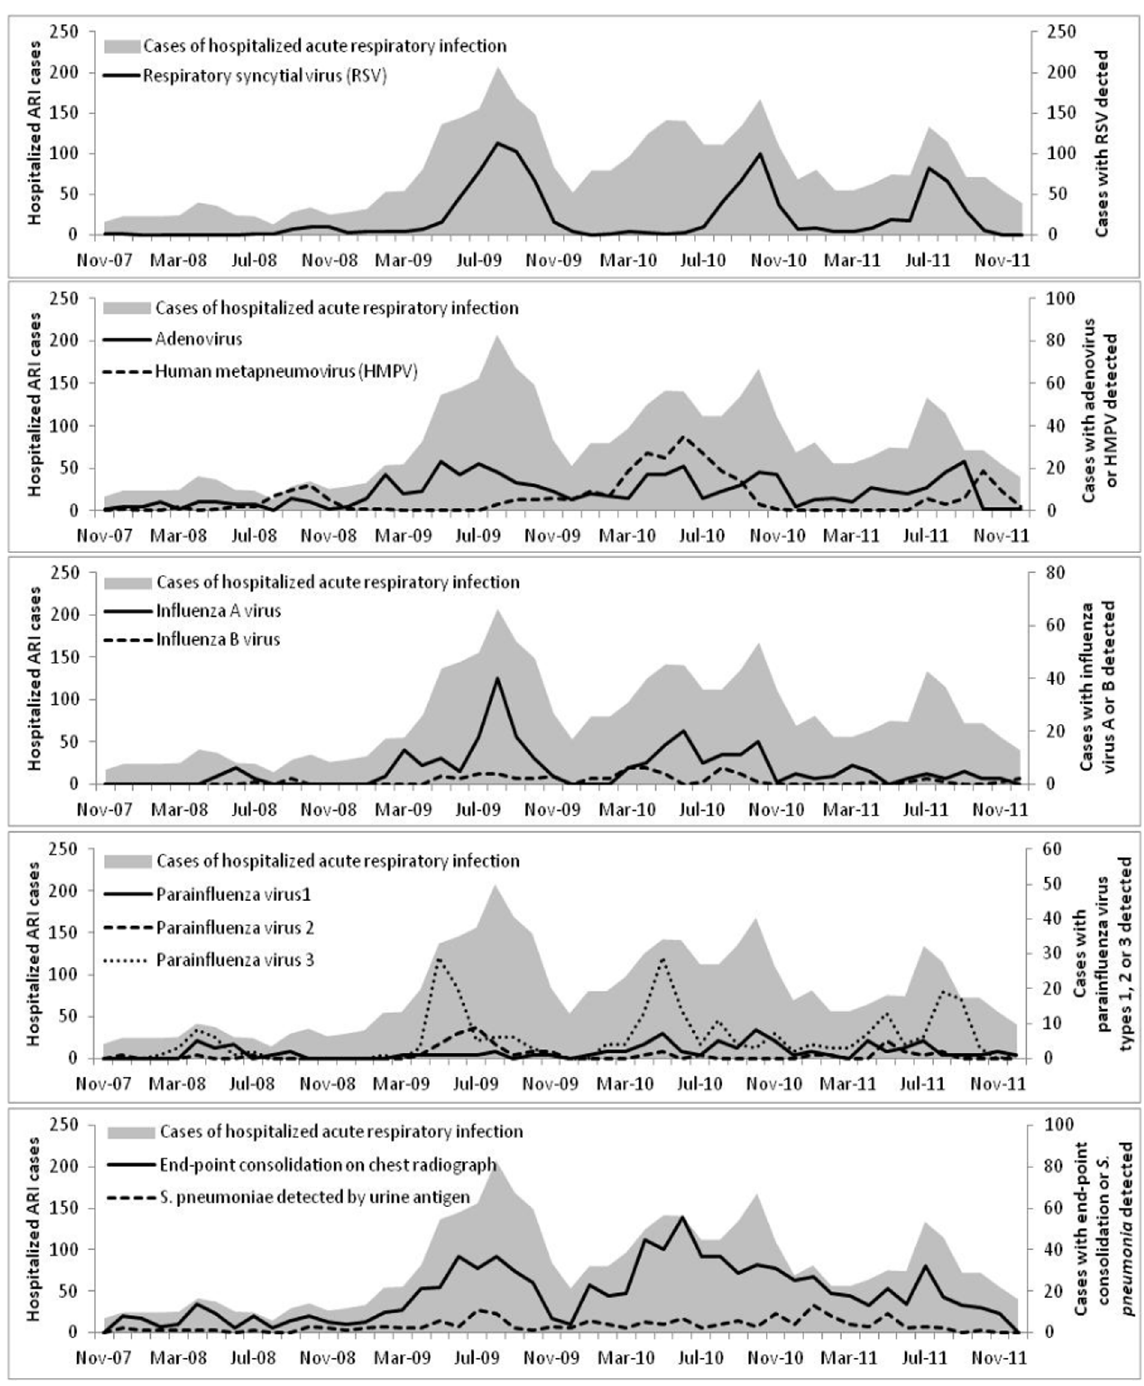
Figure 3. Seasonality of respiratory pathogens and chest radiograph findings. Cases of hospitalized acute respiratory infection (left axis) and number of case-patients with positive results for viral pathogens, Streptococcus pneumoniae urine antigen or with endpoint consolidation on chest radiograph (right axis, with varied scales), by month.